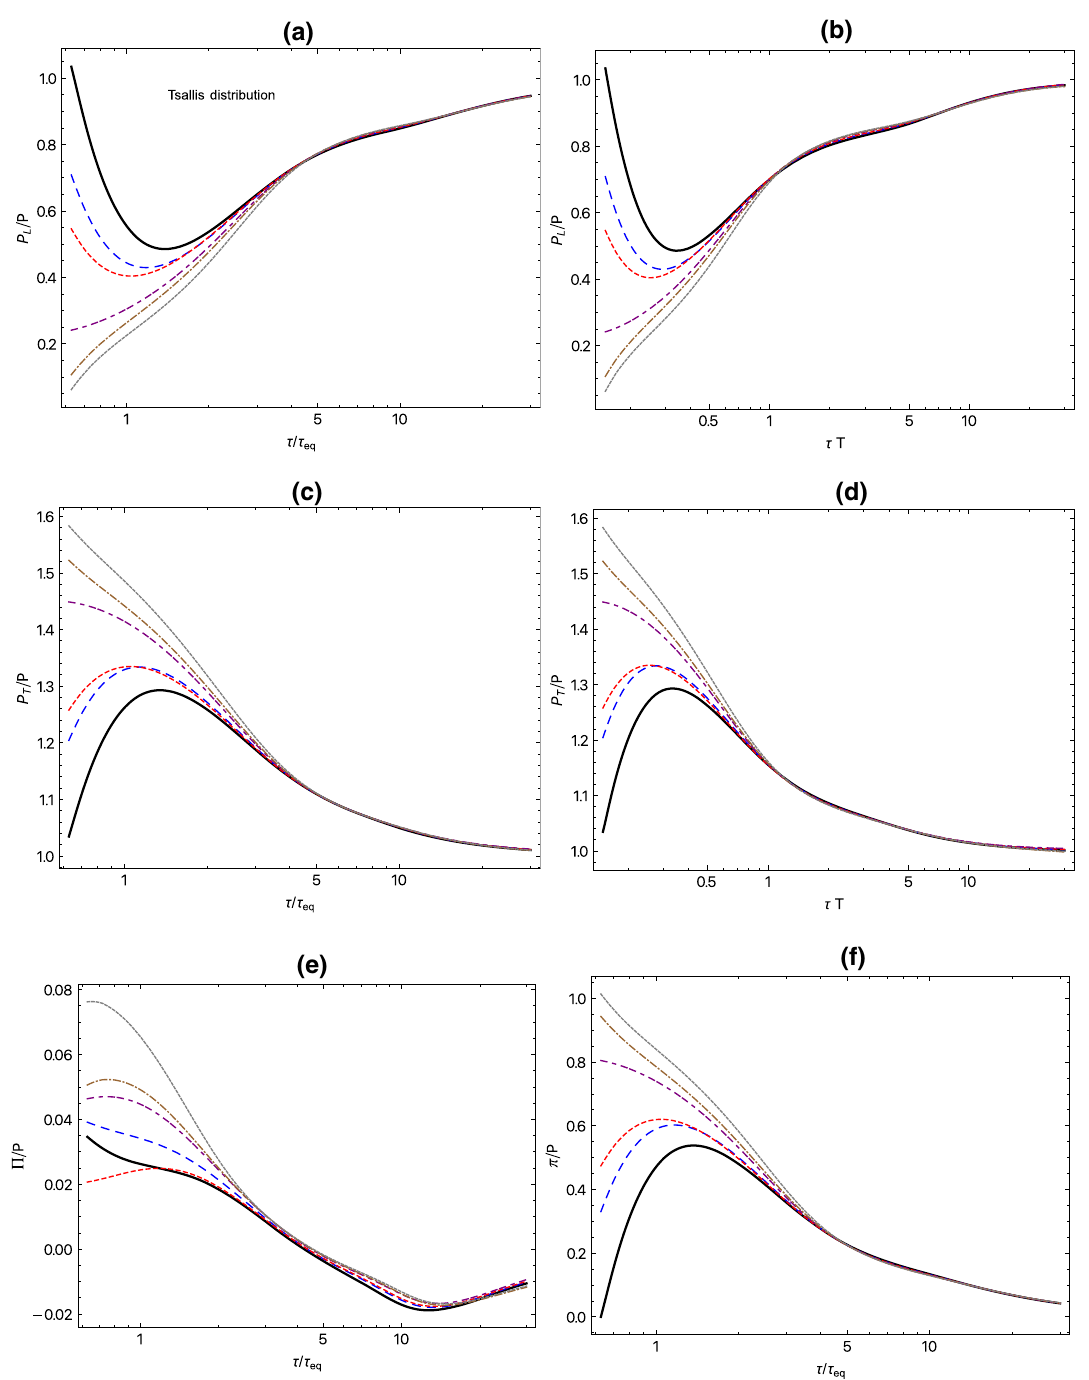
Fig. 4 Same as Fig. 3 with Tsallis distribution used instead of Boltzmann distribution. Similar initial conditions are used as in Fig. 3 with q 0 taken to be 1 . 1 in all panels and for all